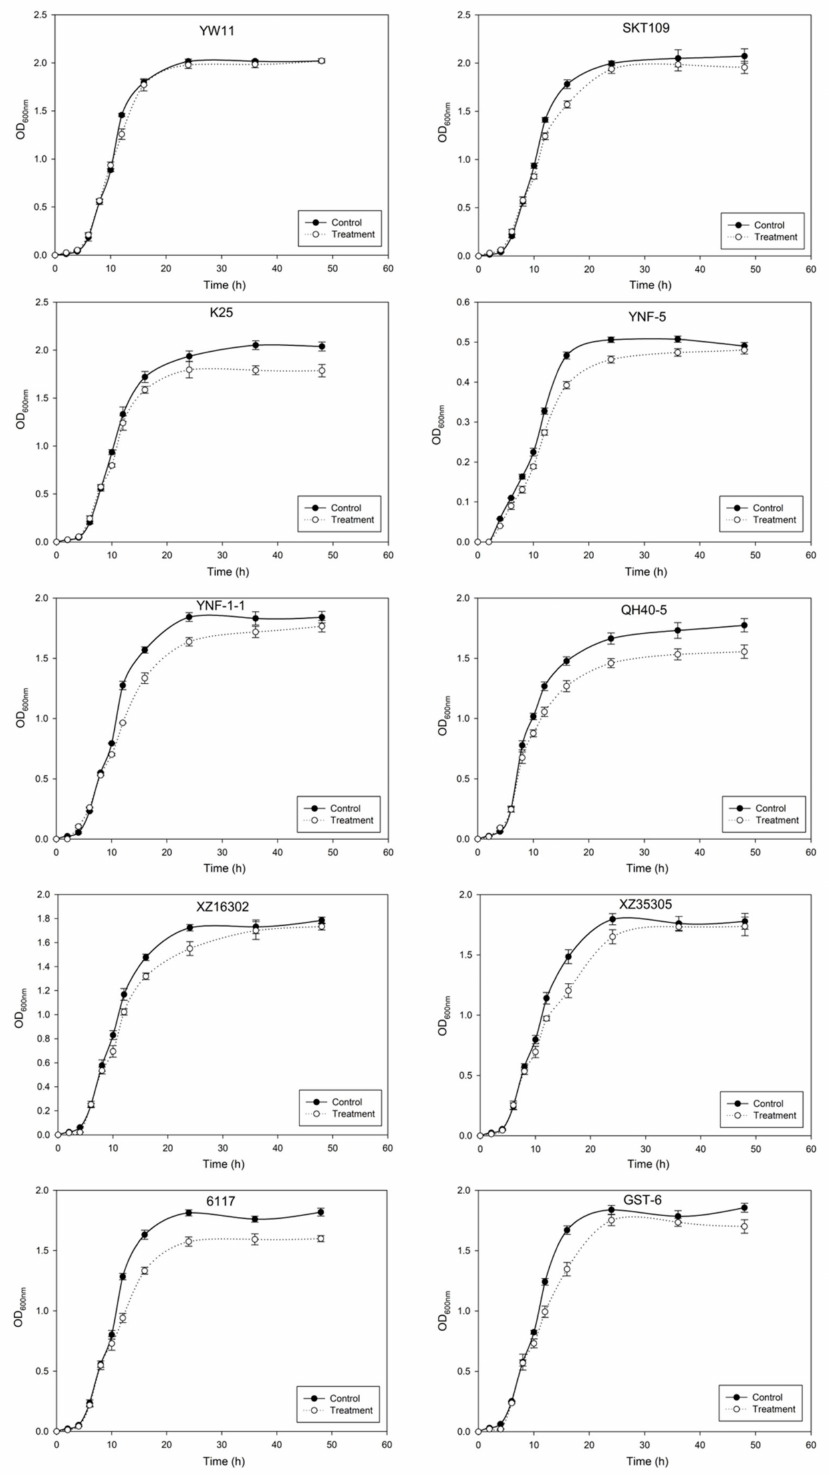
Figure 2. E ff ect of lead on the growth of di ff erent lactic acid bacterial strains. Control: lactic acid bacteria (LAB) strains in lead-free MRS medium; treatment: LAB strains in MRS medium containing lead ions (100 mg / L). OD 600nm : absorbance of medium at optical density